Question: Briefly state, in one sentence, what is plotted here.
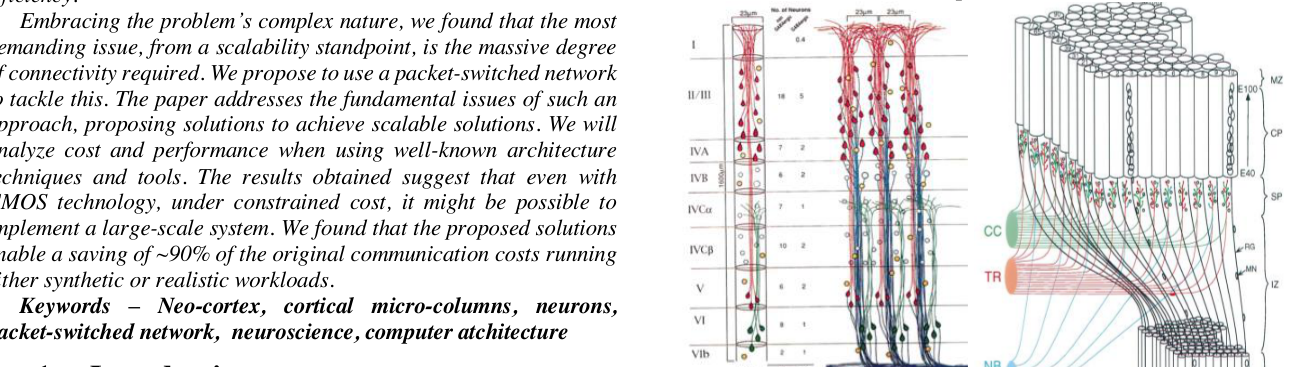
Answer: (a) Cortical columns, (b) Cortical Macro-columns  Initially George and Hawkins [21] hypothesized how the  cortex might implement such a memory structure in order to  fulfill the biological requirements. A theory has been built on the  hypothesis that the cortex works as a self-associative1 memory,  hierarchically structured as a Hierarchical Temporal Memory  (HTM) [25][34]. The theory, which is purely influenced by  neuroscience observations, includes an algorithm, called the  Cortical Learning Algorithm (CLA) that provides the rules for  storing and retrieving information i.e. learning and making  predictions. The idea has been used in practical problems such  as  anomaly  detection,  sequence  prediction,  pattern  identification, natural language processing, etc. At this point in  time, the theory can describe the behavior of the upper layers in  the cortical column. Hopefully, the hierarchy’s inner workings